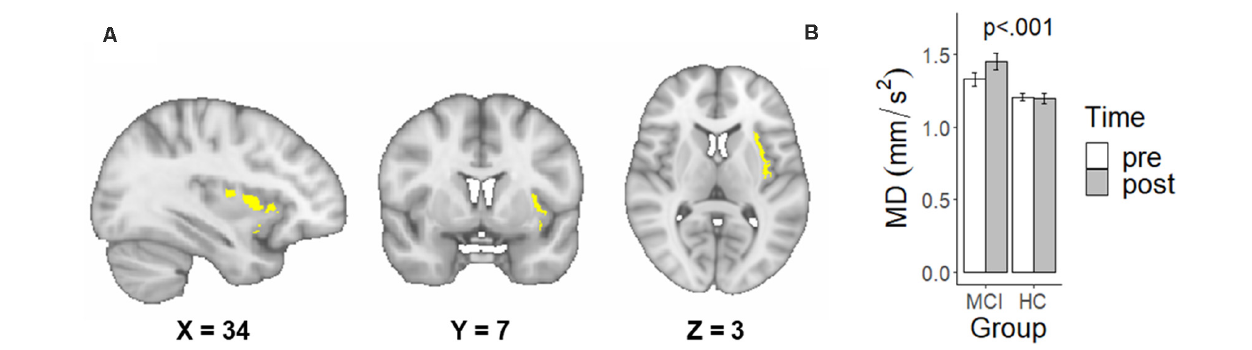
FIGURE 1 | A significant family-wise error corrected interactive effect of Group × Time on mean diffusivity (MD) in the left insular cortex. (A) Sagittal, coronal, and axial view of the significant interaction cluster and the location of peak difference in MNI space using radiological convention. (B) Mean and standard deviations of raw MD values extracted from the significant interactioncluster, not controlling for